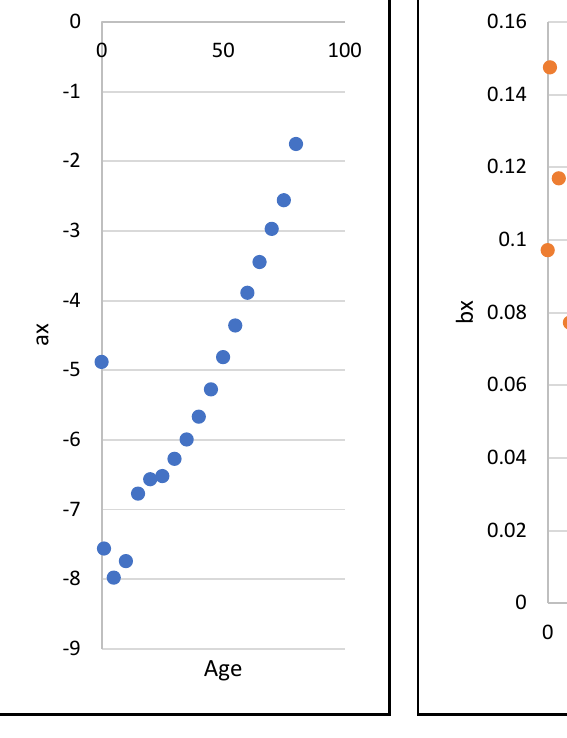
Figure 2. Malaysian Population Mortality Rates 1991–2018.